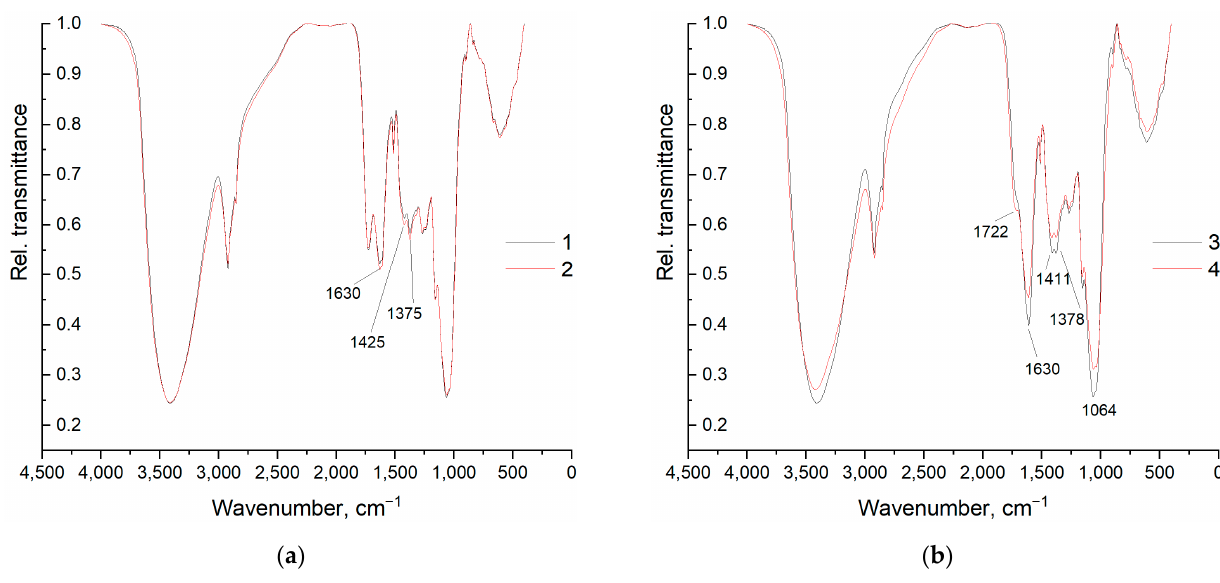
Figure 10. FTIR spectra of MAP ( a ) and MCAP ( b ) before (1, 3) and after (2, 4) copper sorption: initial copper concentration is 150 mg/L, contact time is 30 min, reaction temperature is 25 °C.